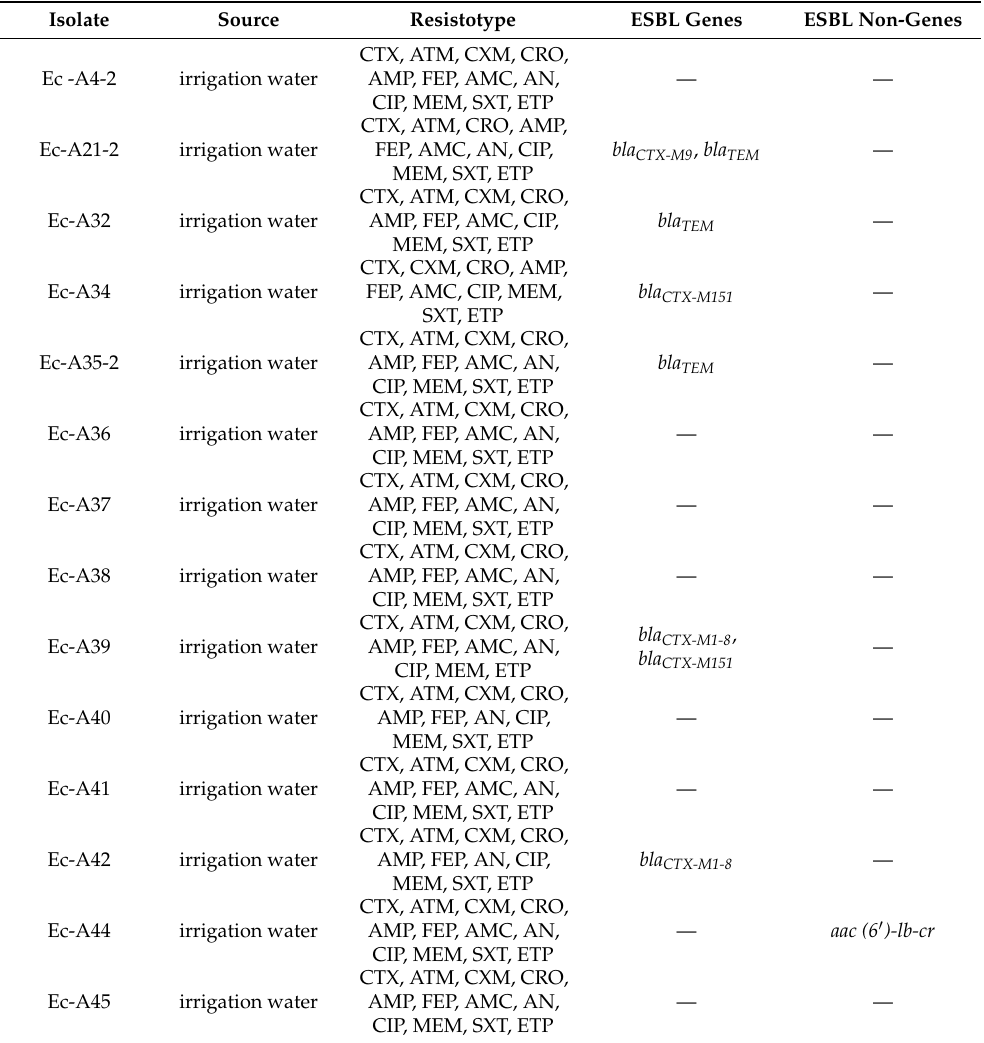
Table 2 shows the resistotype, ESBL, and non-ESBL of the E. coli strains isolated from the Honeydew melon farm and packing facility in Hermosillo, Sonora. Thirty-two E. coli strains were resistant to five or more categories of antibiotics, classifying them as multidrug-resistant. When determining ESBL genes, the bla TEM gene (15.6%) was the most prevalent, detected mainly in strains isolated from the irrigation water. The single genes associated with antibiotic resistance ( bla CTX-M151 , bla CTX-M1 & 8 , and bla CTX-M9 ,) and several gene associations ( bla CTX-M1 & 8 with bla TEM , bla CTX-M1 & 8 with bla CTX-M151 , and bla CTX-M9 with bla TEM ) were identified in the E. coli isolated from irrigation water, discarded melon, and harvested melon. In the same way, it was possible to identify the presence of E. coli strains with quinolones ( aac (6 (cid:48) )-lb-cr and qepA ) resistance genes in the irrigation water and harvested melon. These results emphasize that strains of E. coli that carry a combination of antibiotic-resistant genes pose a clinical threat due to human infection. Table 2. Resistotype, ESBL genes, and non-ESBL genes among E. coli isolates obtained from the Honeydew melon farm and packing